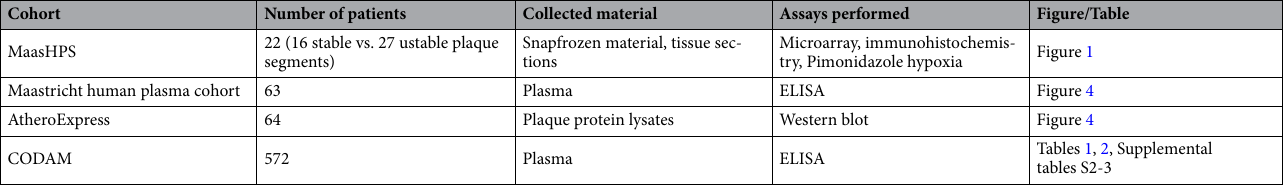
Table 4. Overview human patient cohorts.